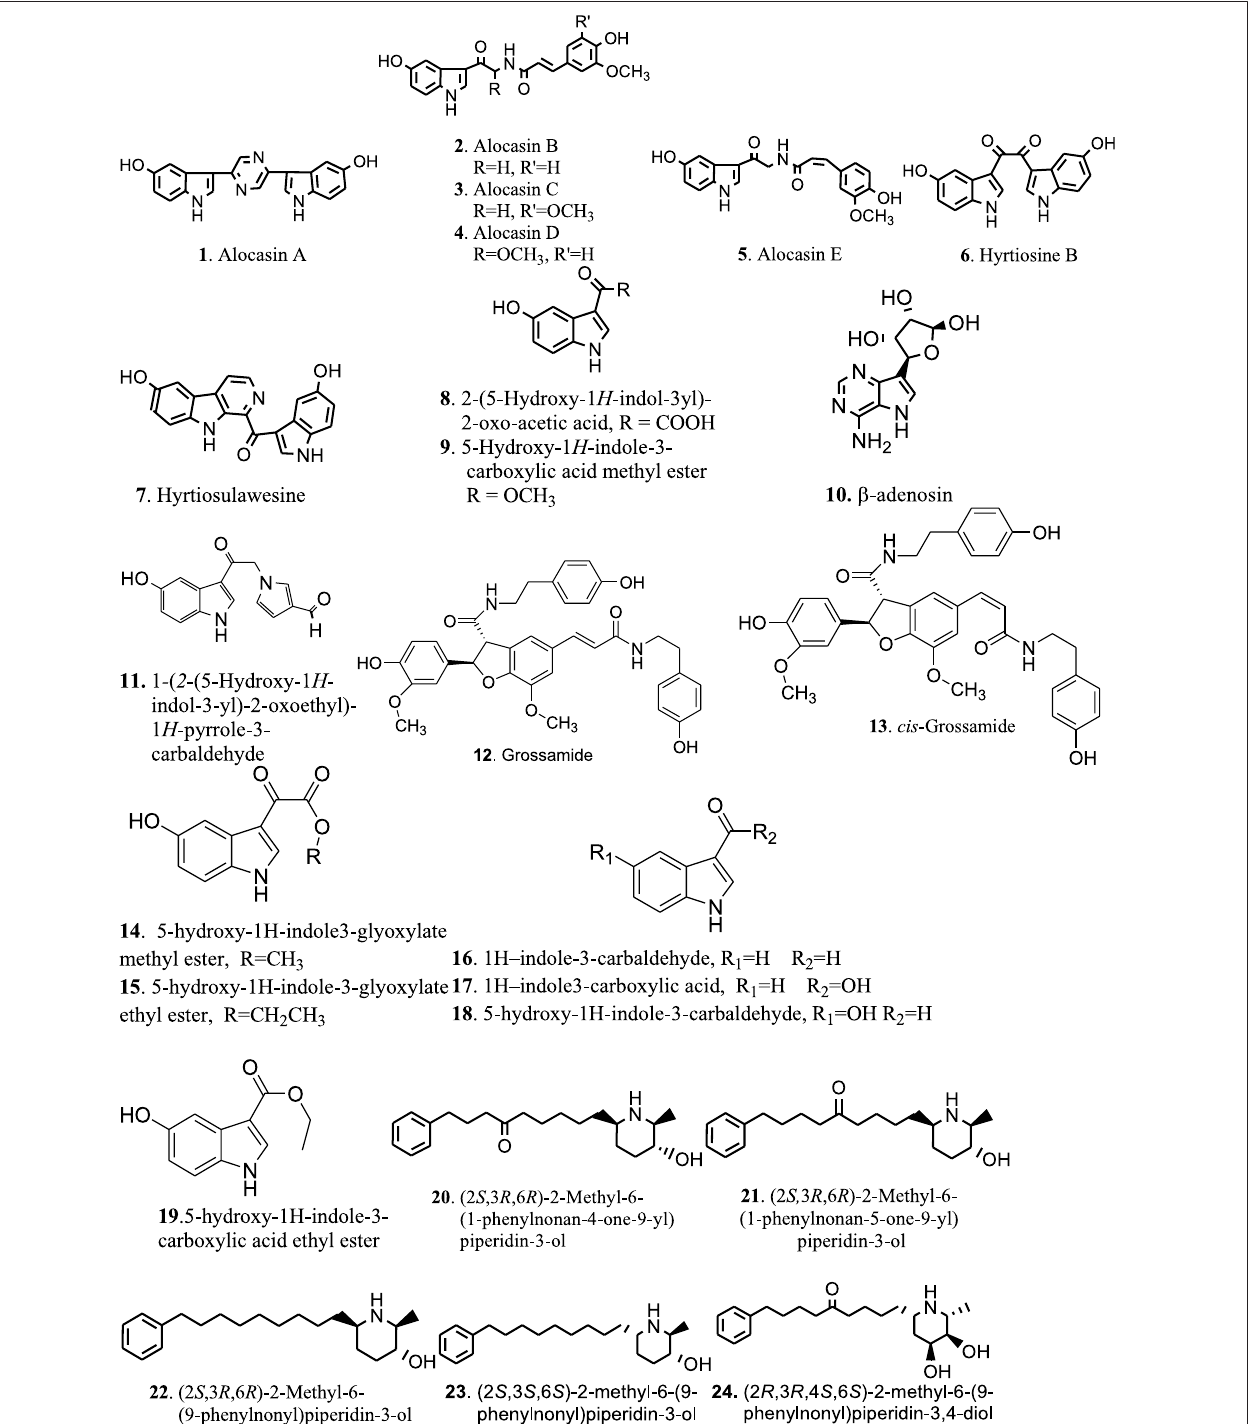
Frontiers in Pharmacology |